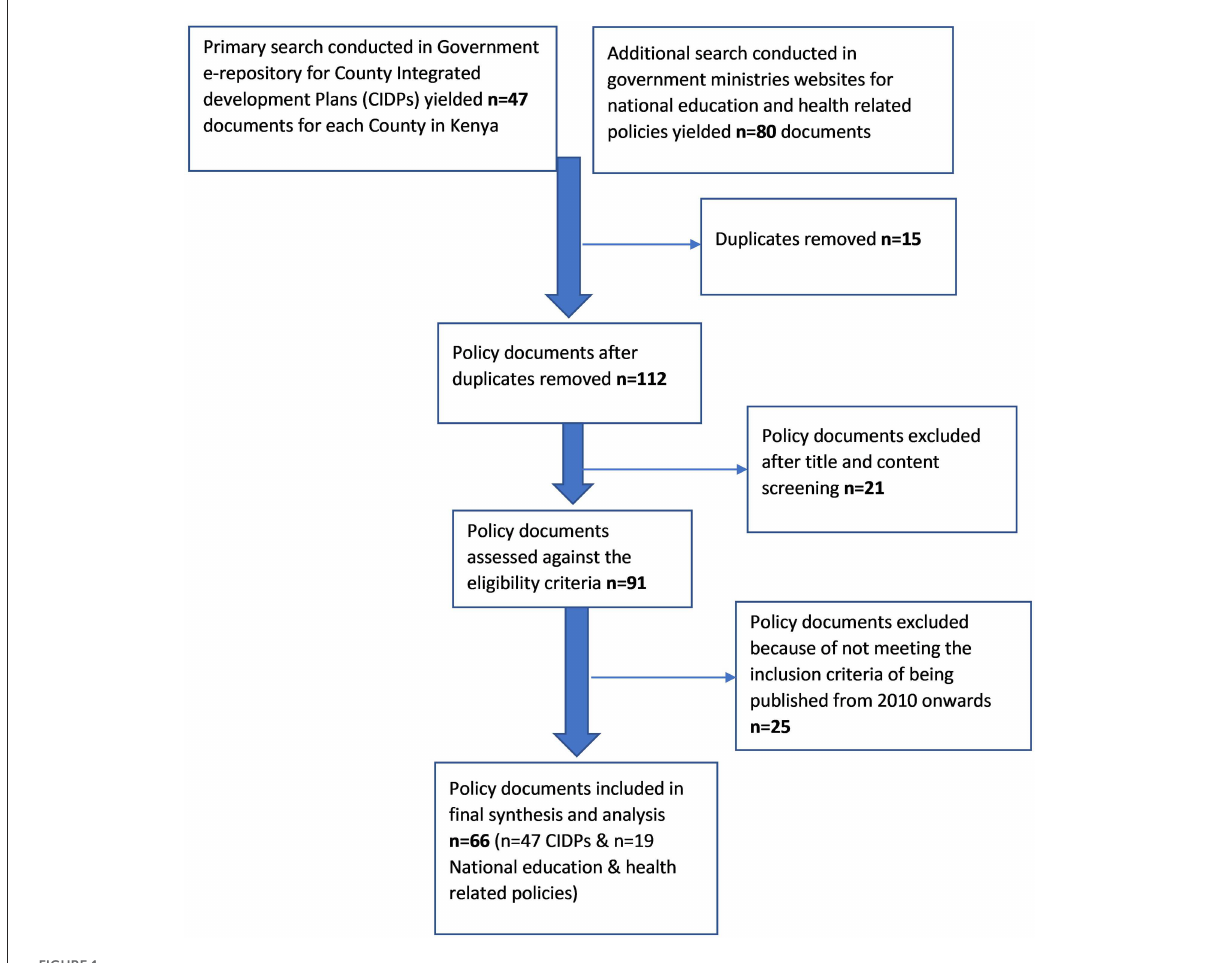
FIGURE1 Policy documents selection